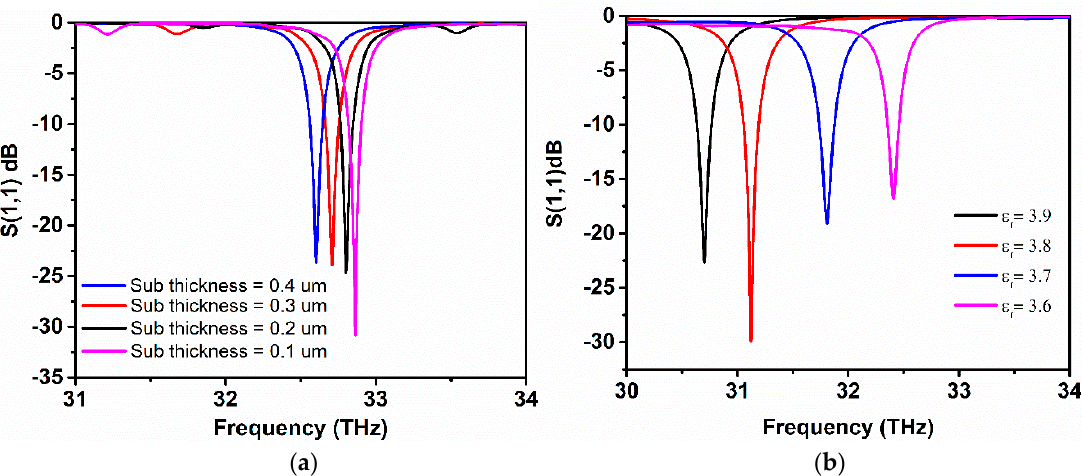
Figure 9. ( a ) Effect of the increasing substrate thickness on the resonance frequency; and, ( b ) The effect of increasing substrate permittivity on graphene antenna performance. of increasing substrate permittivity on graphene antenna